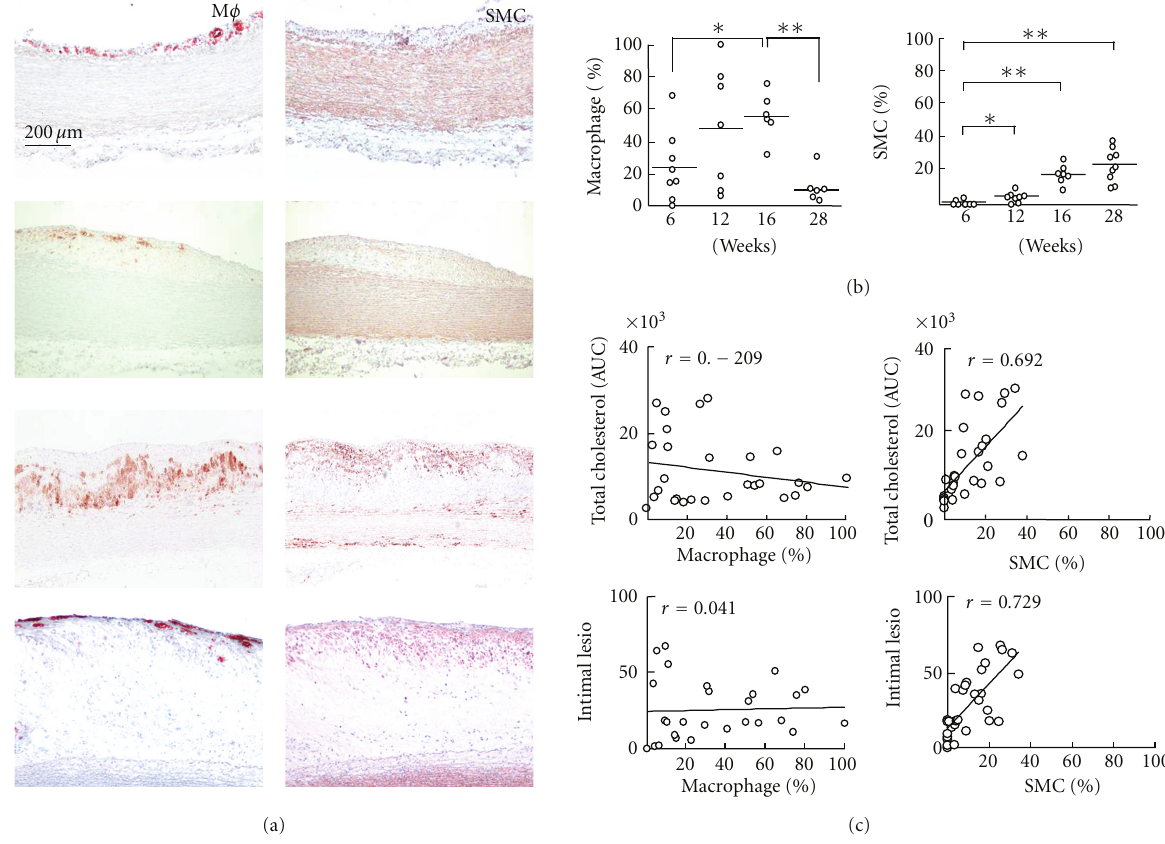
Figure 4: Immunohistochemical investigations of the lesions. Representative images are shown for macrophages (M ϕ ) and SMC α -actin (a). M ϕ - and SMC-positive areas were determined using an image analysis system (b). The M ϕ s and SMCs were compared with cholesterol exposure (AUC) and intima lesion area, respectively (c). The data are expressed as the means ± SEM. n = 6–8 for each group. ∗ P < 0 . 05 and ∗∗ P < 0 . 001.